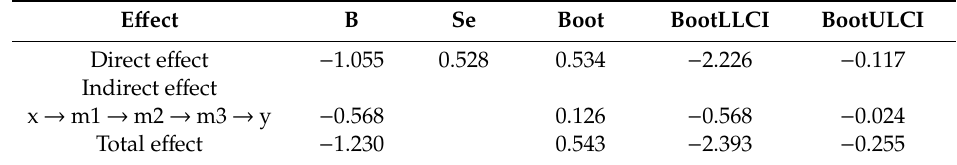
Table 3. Serial mediation of depression stigma, attitude toward psychiatric help, and depression toward suicidal ideation among children ( n = 103 parent–child pairs). E ff ect B Se Boot BootLLCI BootULCI Direct e ff ect − 1.055 0.528 0.534 − 0.117 Indirect e ff ect x → m1 → m2 → m3 → y − 0.568 0.126 − 0.568 − 0.024 Total e ff ect − 1.230 0.543 −